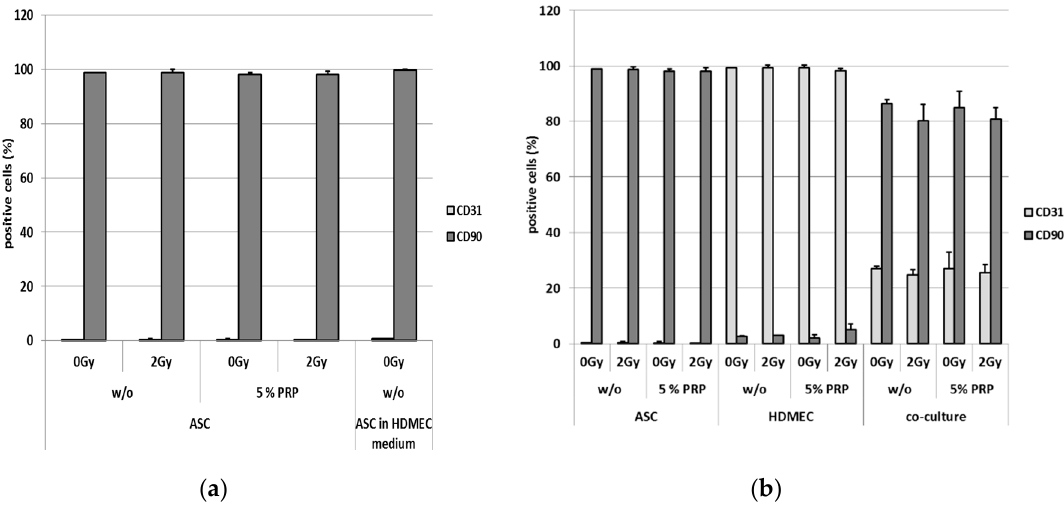
Figure 1. Flow cytometric analysis of the surface markers CD90 and CD31. CD31 is highlighted in light grey, CD90 in dark grey. Samples were treated with 5% platelet-rich plasma and irradiated using a dose of 2 Gy (J/kg). Data for control cells are given. ( a ) Comparison of adipose-derived stem cells in α -MEM and adipose-derived stem cells in EC-Medium; ( b ) Analysis of CD90 and CD31 of adipose-derived stem cells, microvascular endothelial cells and the respective co-culture.